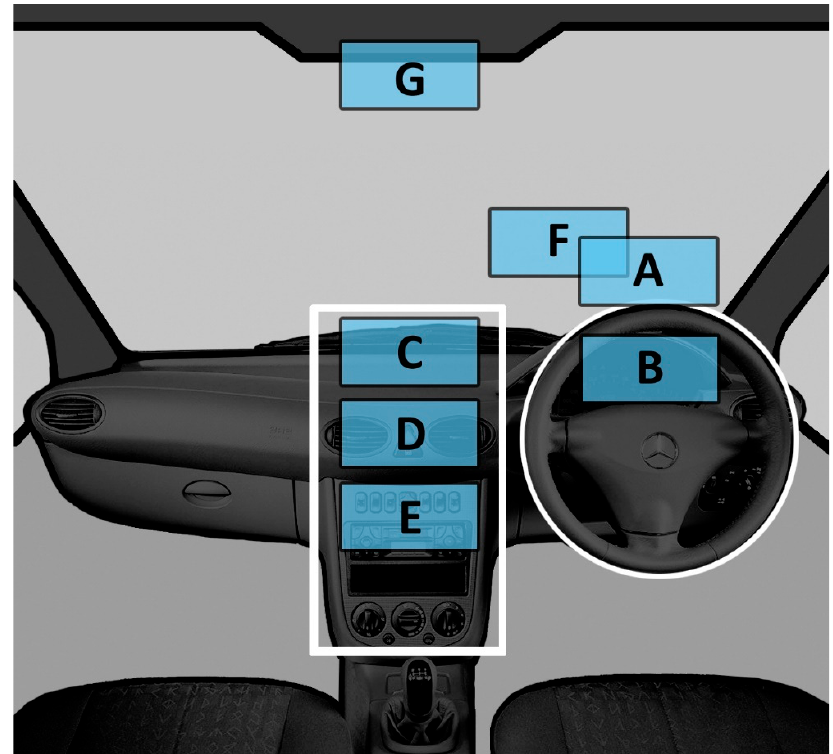
Figure 8. Diagrammatic representation of the driver’s cockpit and the positions that could accommodate a touchscreen. Figure reconstructed from [46].